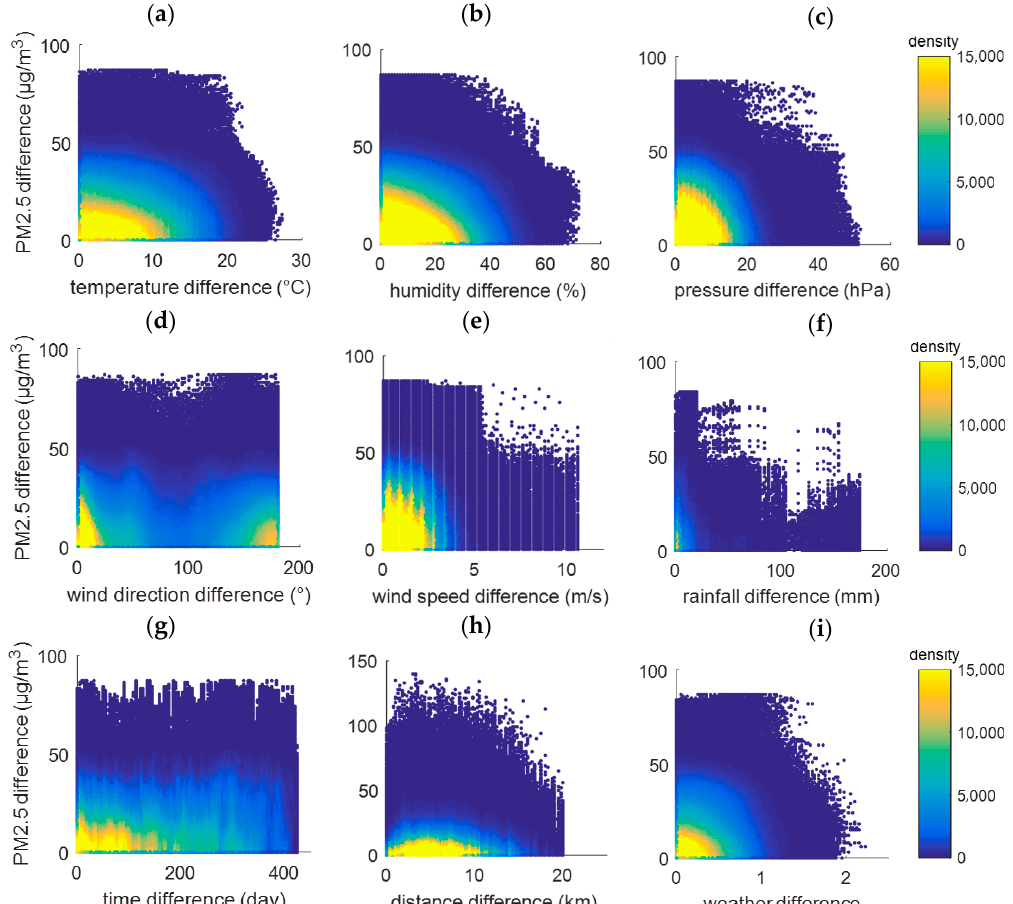
Figure 3. Relationship between ( a ) temperature, ( b ) humidity, ( c ) pressure, ( d ) wind direction, ( e ) wind speed, ( f ) rainfall, ( g ) time, ( h ) distance, and ( i ) weather difference and PM2.5 value error.